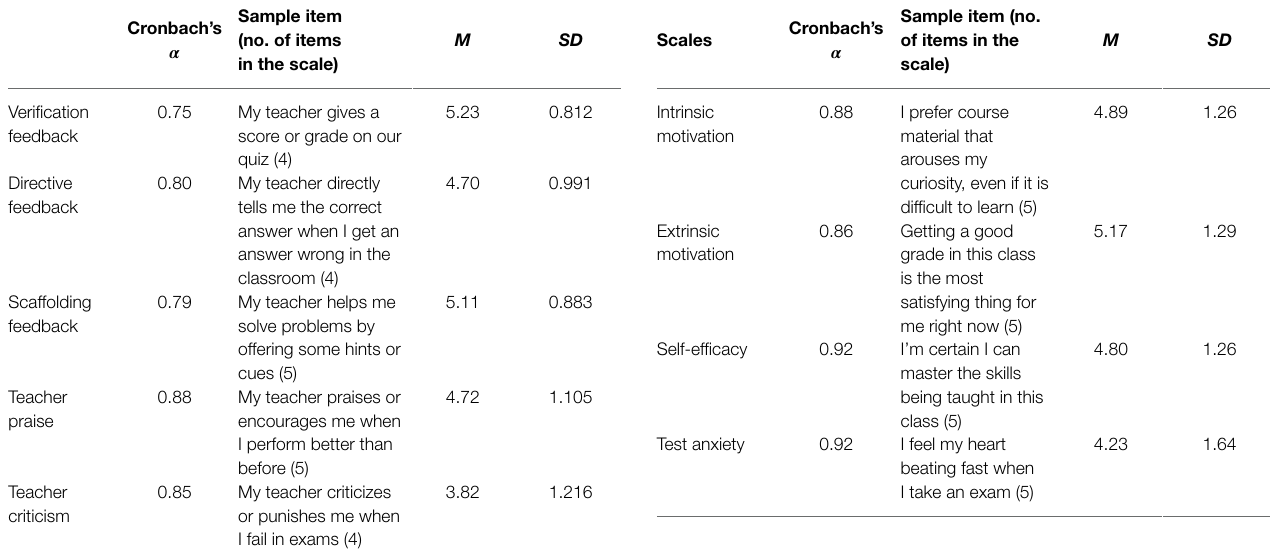
TABLE 1 | Sample items, internal consistency coefficients and descriptive statistics for the variables of students’ perceptions of teacher feedback measured in this study.